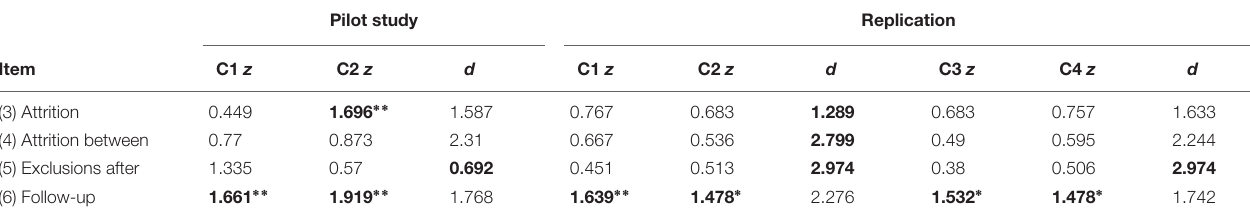
TABLE 2 | Testing assumptions for quantitative